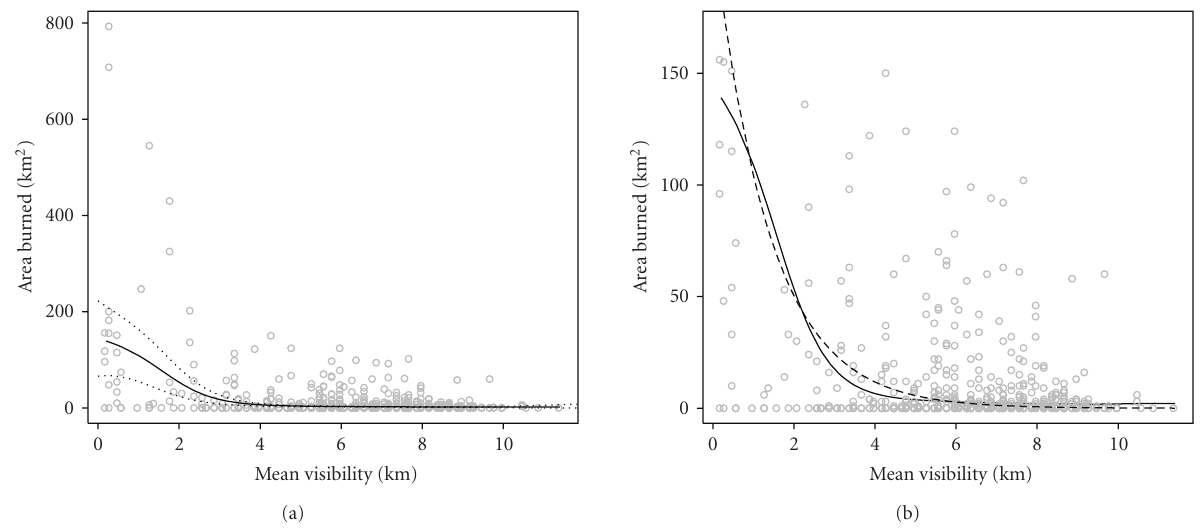
Figure 3: Estimate (solid line) of total area burned (km 2 ) per day by mean visibility, smoothed using a Gaussian kernel smoother and bandwidth of 0.9 kilometers, calculated by modified likelihood cross-validation. (a) All the data are shown, (b) only days with burn areas less than 180km 2 are shown, in order to highlight the behavior of the kernel smoother, and the fit of an exponential curve (dashed curve) is